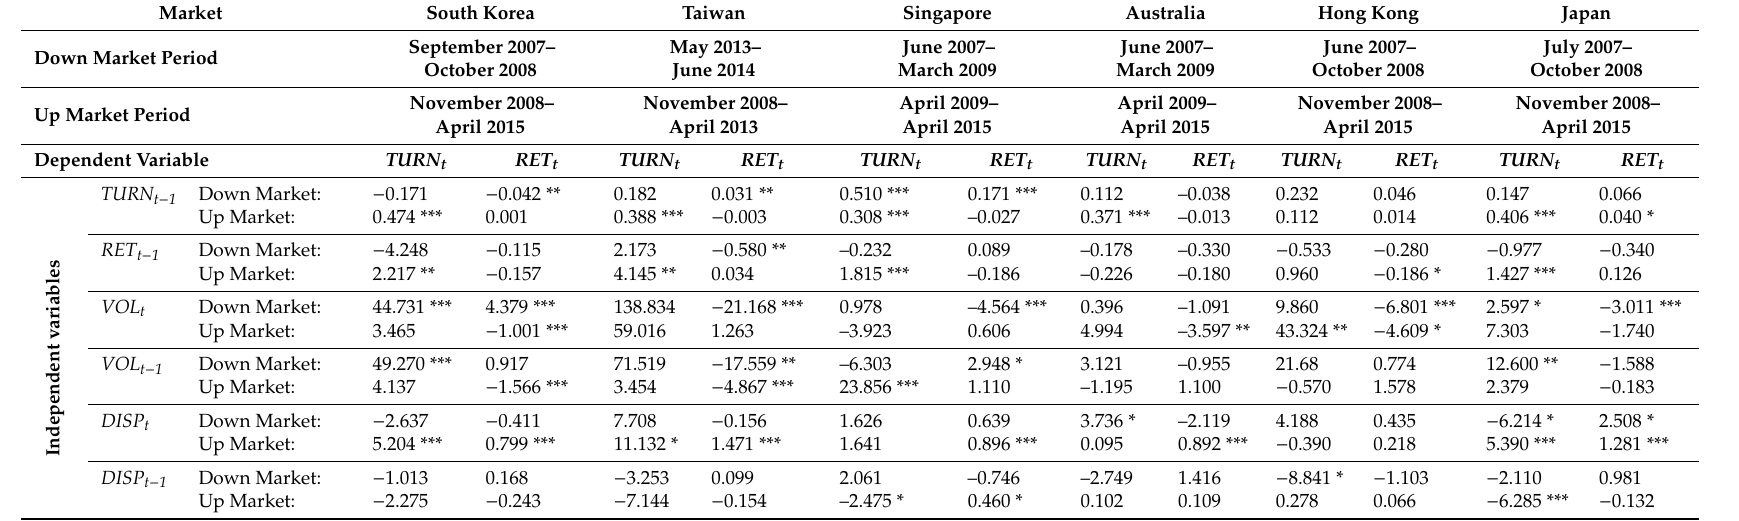
Table 4. Sub-period VAR